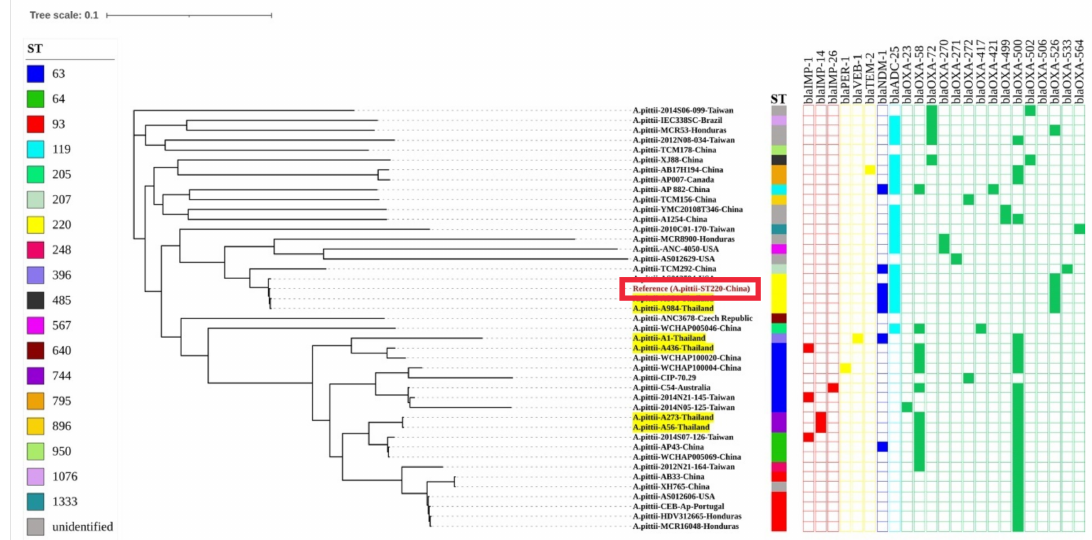
Figure 3. Whole-genome phylogeny analysis of A. pittii generated by CSI Phylogeny and visualized with interactive tree of life tool. The whole genome sequence of A. pittii in our studies is shown in yellow highlight and A. pittii -ST220-China as a reference genome is denote in red square box. Sequence type (STs) and β -lactamase genes are shown in each isolate. The filled symbols reveal the presentation of the genes, whereas unfilled symbols reveal their